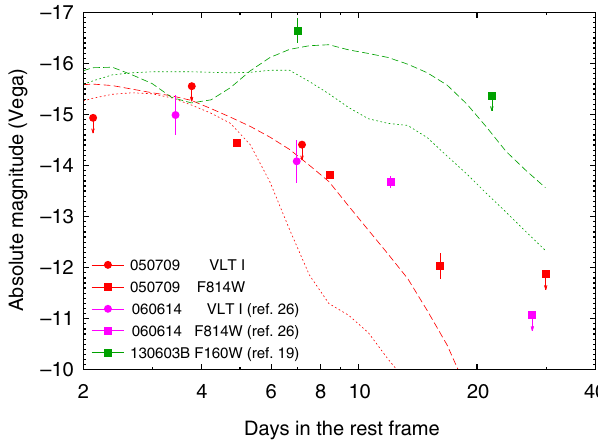
Figure 2 | Comparison of the lightcurves of macronova candidates and theoretical models. Absolute Vega magnitudes versus rest frame time of the macronova candidates in sGRB 050709, hGRB 060614 (ref. 26) and sGRB 130603B 19 . The red dashed line is the same as the dynamical ejecta macronova model I -band emission presented in Fig. 1 (the green dashed line represents the H -band emission), whereas the red dotted line is the disk-wind ejecta macronova model I -band emission light curve 65 for M ej ¼ 0 : 03 M (cid:2) and V ej ¼ 0.07 c (the green dotted line represents the H -band emission). It is noteworthy that all errors are 1 s statistical errors and the upper limits are at the 3 s confidence